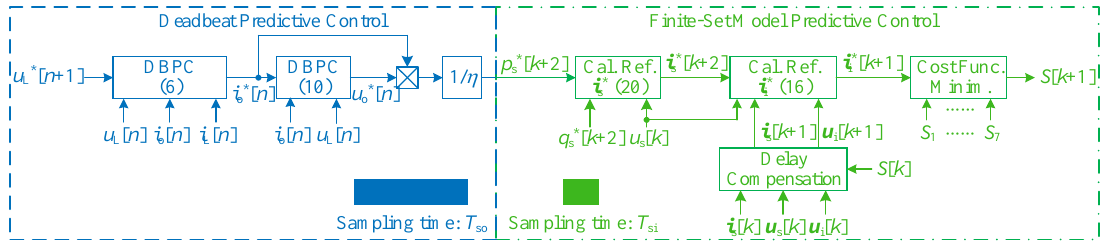
Figure 3. Block diagram of the proposed hybrid control scheme. (Different colors indicate different sampling times.)